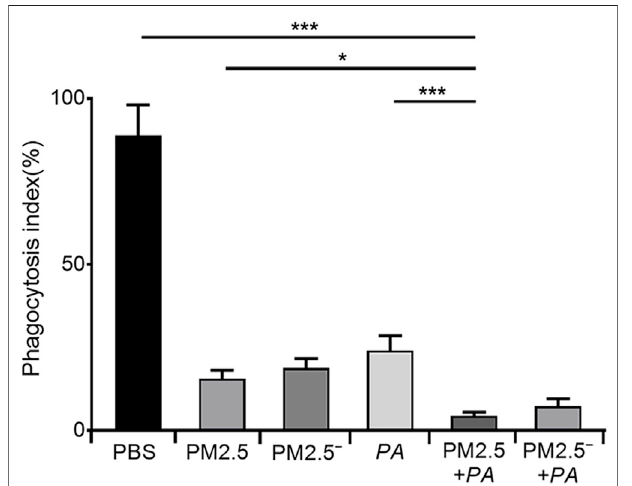
FIGURE 1 | Costimulation by PM2.5 and P. aeruginosa can reduce the phagocytic ability of mouse alveolar macrophages. In the experimental groups, the fi nal concentrations of the PM2.5 and PM2.5 — samples were 100 μ g/ml, and the multiplicity of infection (MOI) between P. aeruginosa and the cells was 10:1 (number of bacteria:number of cells). Each group was stimulatedfor12 hwiththecorrespondingsample,andthecontrolgroupwas treated with an equal volume of PBS. The experiment was repeated three times. PBS, phosphate-buffered saline; PM2.5, particulate matter less than 2.5 μ m in diameter; P. aeruginosa , Pseudomonas aeruginosa . The data are presented as the means ± SD. One-way ANOVA in SPSS. * p < 0.05, ** p < 0.01, *** p < 0.001.